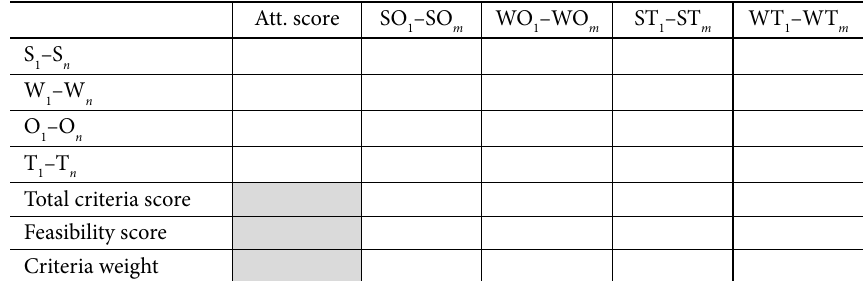
Fig. 1. The first step of the 1. Create a table of alliance strategies (SO, WO, ST, WT) as criteria and motivations (S, O, W, T) based on the SWOT analysis output as in Table 2. Table 2. Fuzzy SWOT-QSPM chart